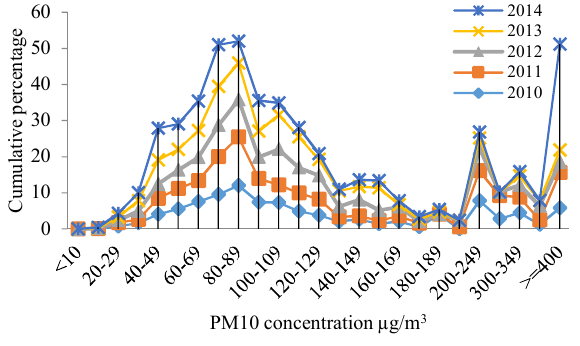
Fig. 4. Cumulative percentage of cases that are exposed to different concentrations of PM